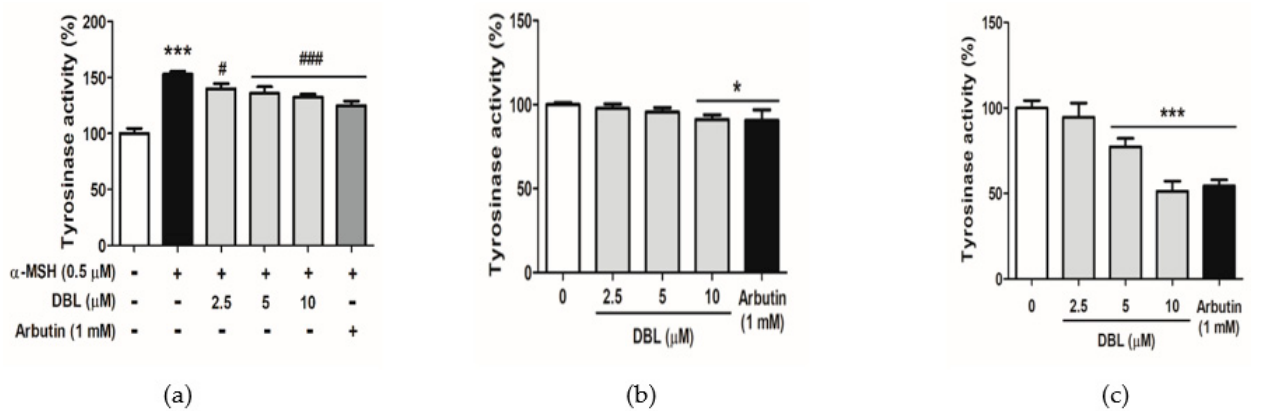
Figure 3. Effect of DBL on tyrosinase activity. ( a ) Tyrosinase activity (%) of B16F10 stimulated with α -MSH and DBL for 48 h. ( b ) Tyrosinase activity (%) of B16F10 treated with DBL for 48 h. ( c ) Tyrosinase activity (%) of HEM cells after 72 h of treatment with DBL. All data have been presented as mean ± SD. Significant difference versus control group: * p < 0.05, *** p < 0.001. Significant difference versus α -MSH-treated group: # p < 0.05, ### p < 0.001. Positive control: 1 mM arbutin.